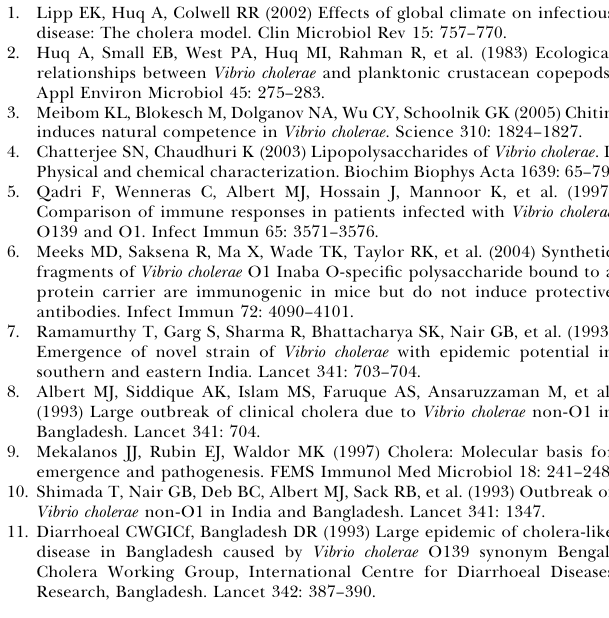
Figure S3. Serogroup Conversion Occurs in Mixed Biofilms